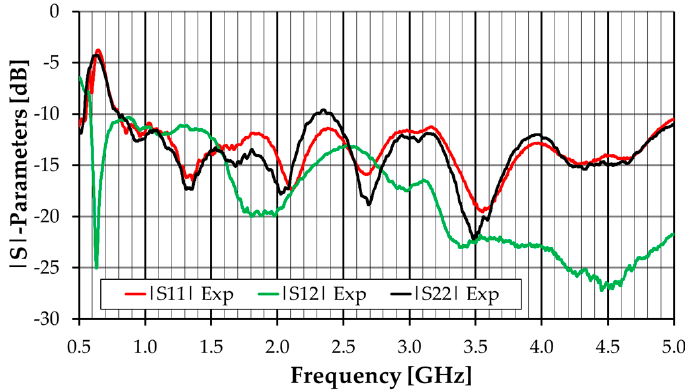
Figure 13. |S|-parameters experimental results of the dual-linearly polarized monopole antenna.